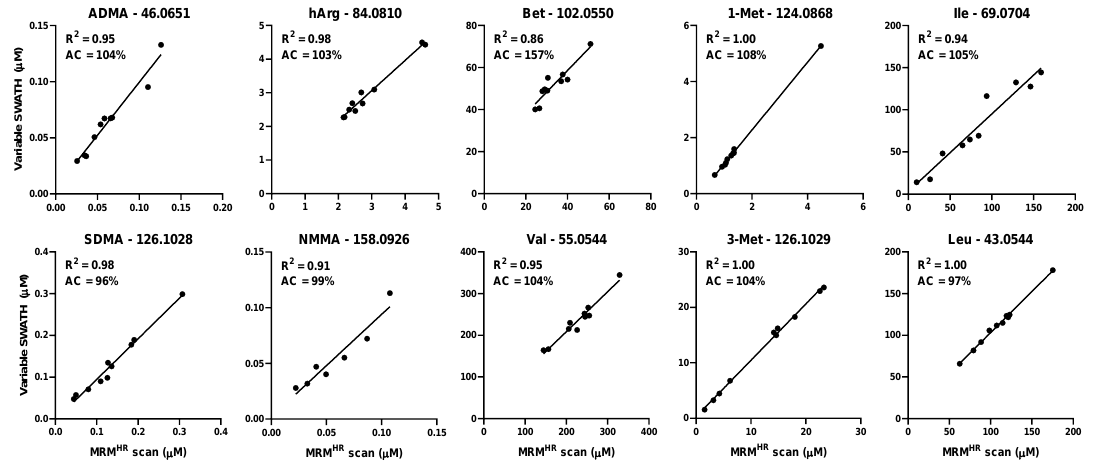
Figure 3. Correlation (R 2 ) and accuracy (AC) of the quantification values of 10 structural isomers in 10 volunteers. Each data point represents the analyte concentration quantified by MRM HR and variable SWATH. The quantification values of the best performing product ion are depicted in the graph. NMMA was not detected in three